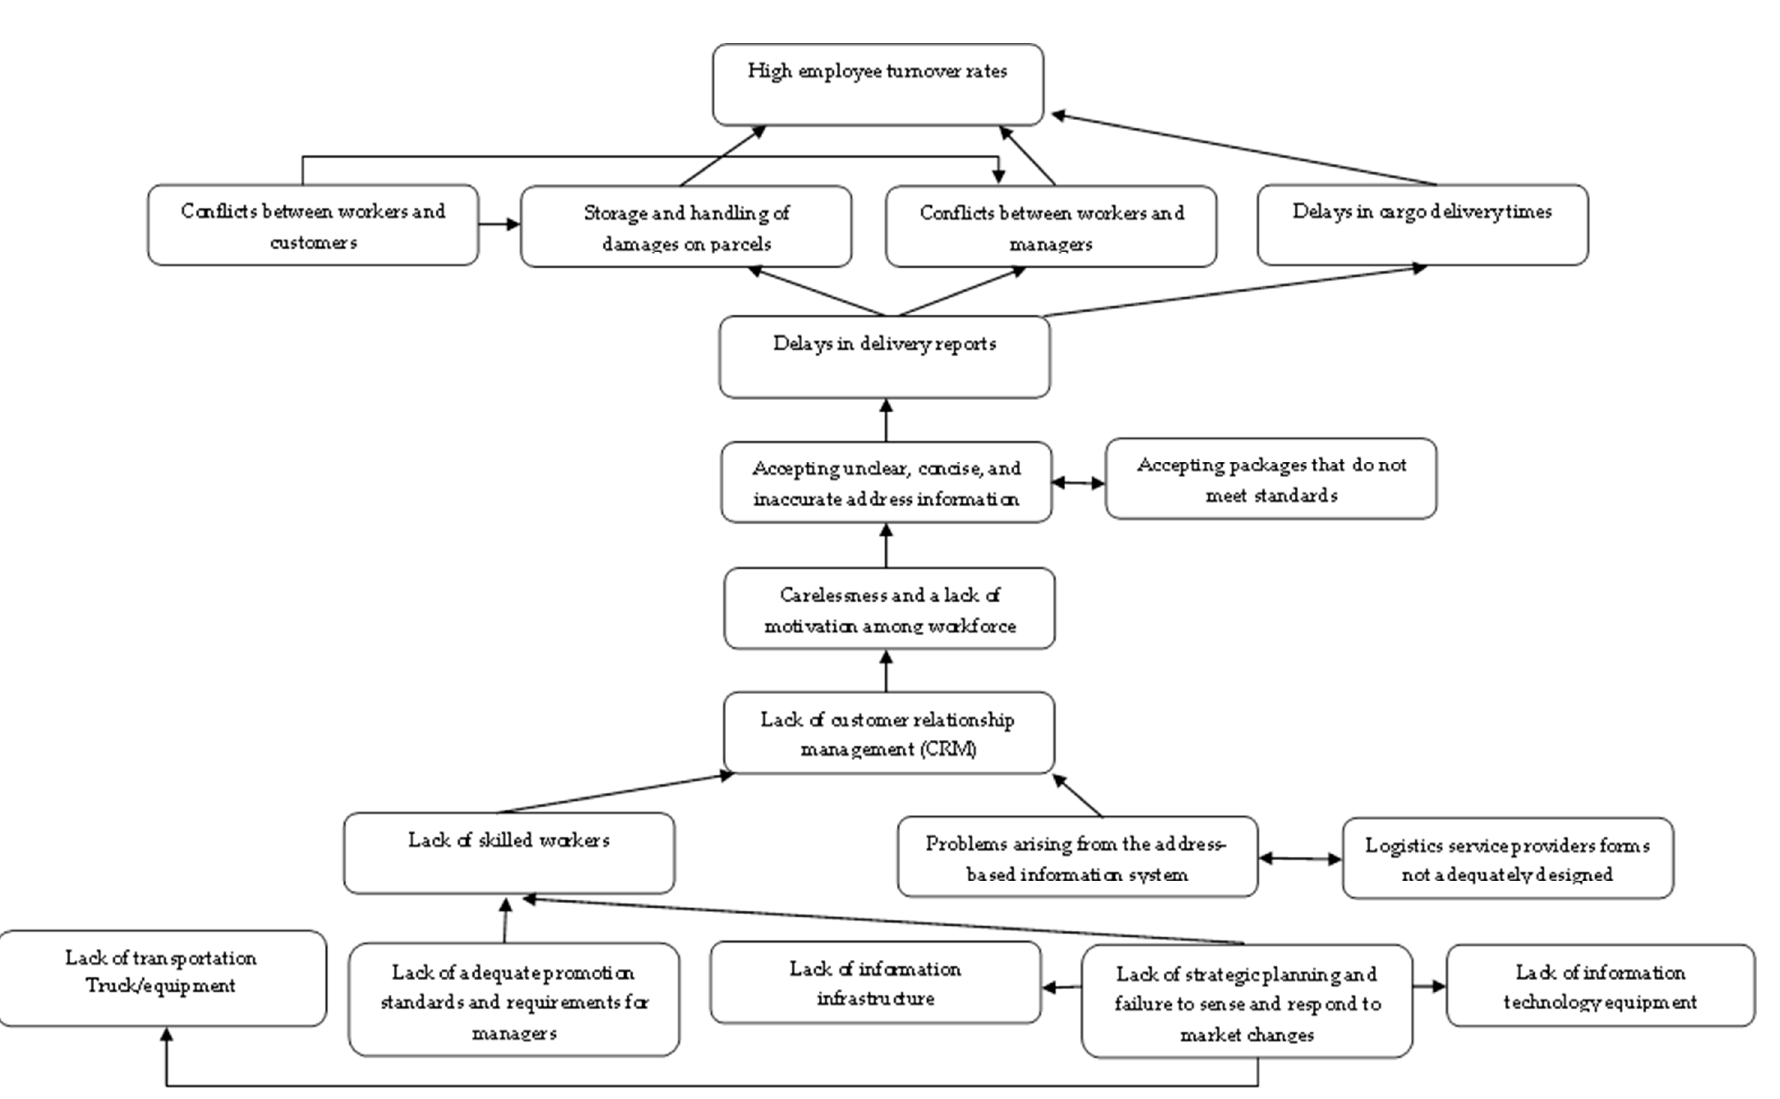
Figure 2. ISM model.